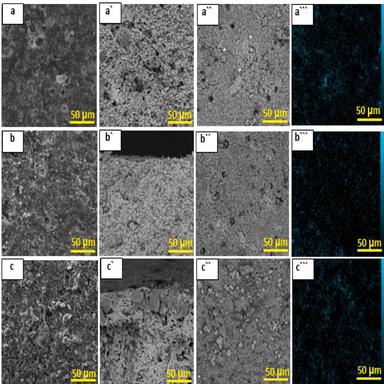
FESEM and EDS mapping of the ceramic membranes incorporated by BFS after oily wastewater treatment. a) Outer surface of M-Z-BFS10, a') Cross-section of M-Z-BFS10, a'`) Inner surface of M-Z-BFS10, a'``) Carbon element on the inner surface of M-Z-BFS10, b) Outer surface of M-Z-BFS20, b') Cross-section of M-Z-BFS20, b'`) Inner surface of M-Z-BFS20, b'``) Carbon element on the inner surface of M-Z-BFS20, c) Outer surface of M-Z-BFS30, c') Cross-section of M-Z-BFS30, c'`) Inner surface of M-Z-BFS30, c'``) Carbo